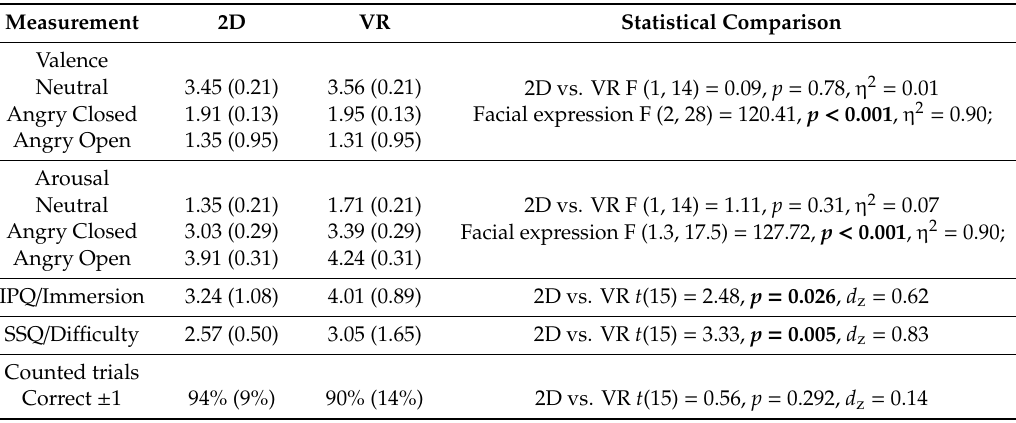
Table 2. Description: behavior and